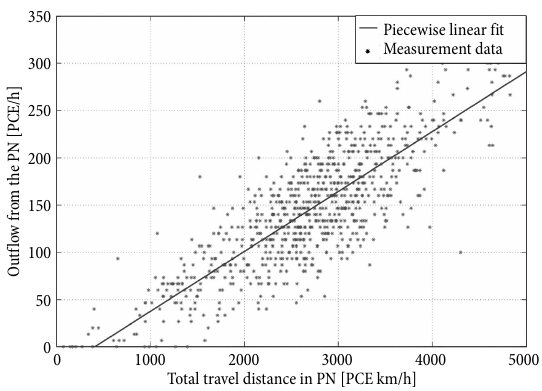
Fig. 3. Linear regression for a parameter Γ